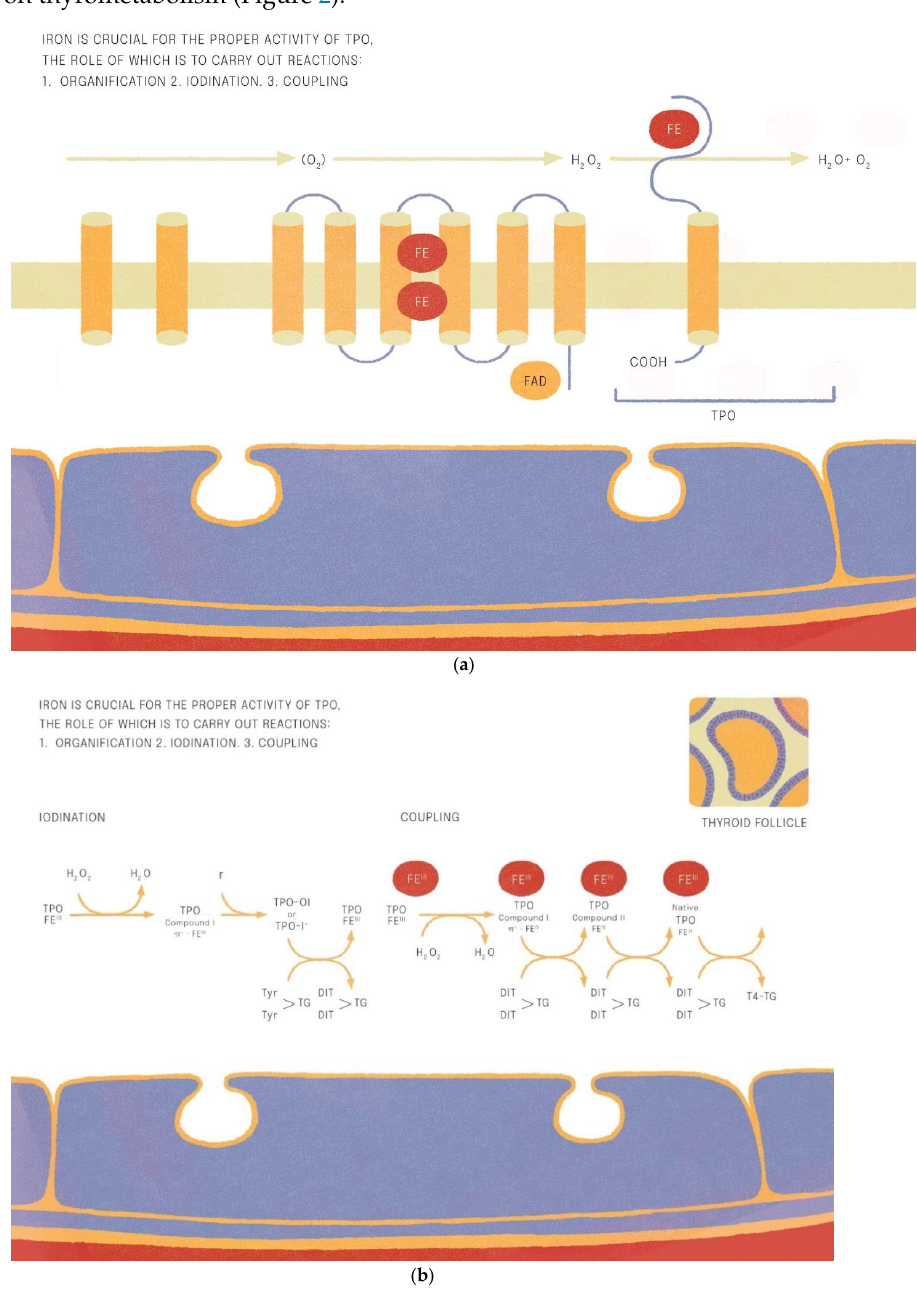
Figure 1. ( a , b ). Iron is crucial for the proper activitity of TPO (thyroid peroxidase).